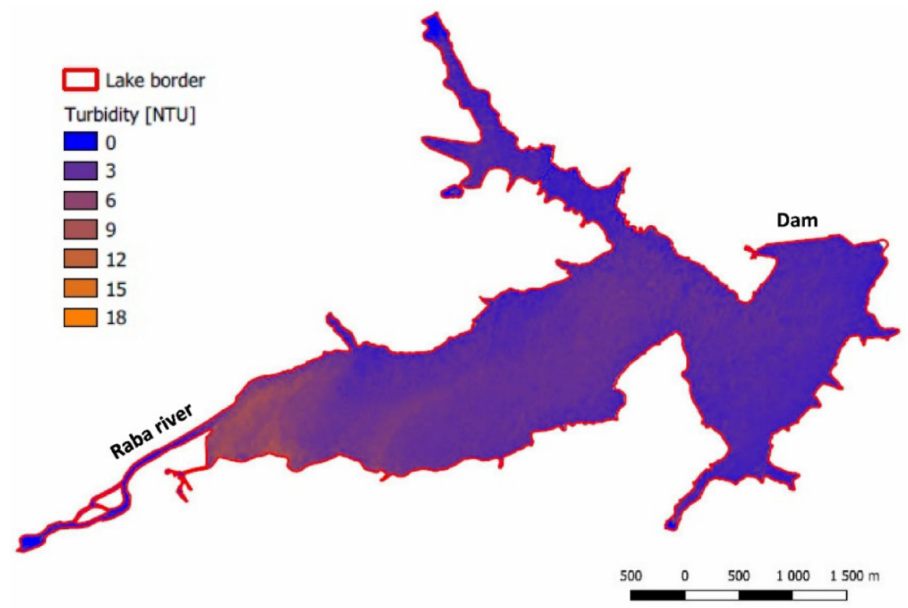
Figure 20. Water turbidity of Lake Dobczyce 9 May 2021 (imagery by Sentinel 2).